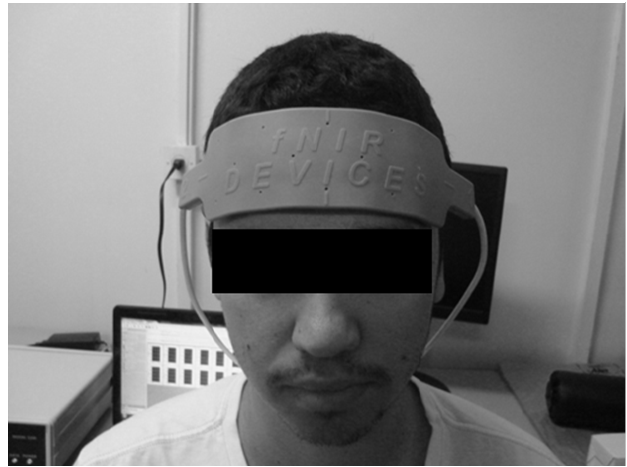
Figure 2. Participant seated using fNIR device to obtain blood flow during motor imagery.